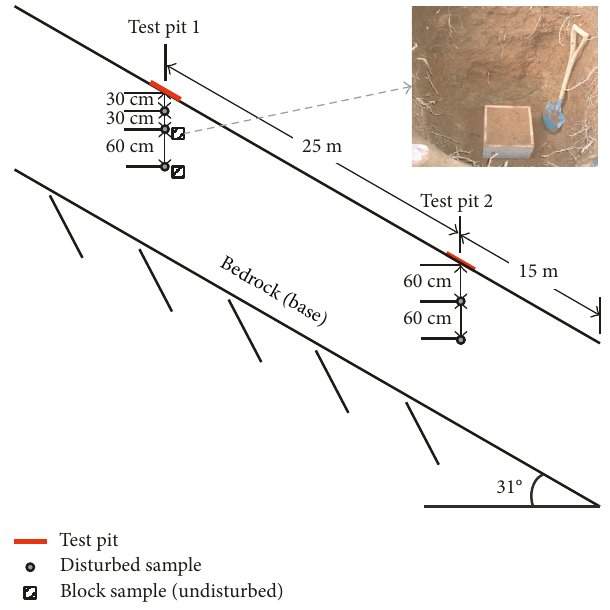
Figure 6: Location of sampling points.